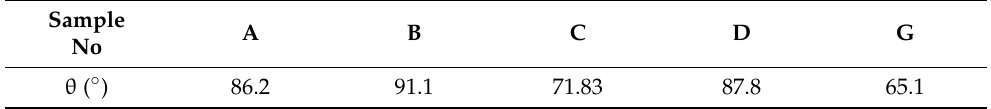
Table 2. The θ value in the overlapping zone of the molten